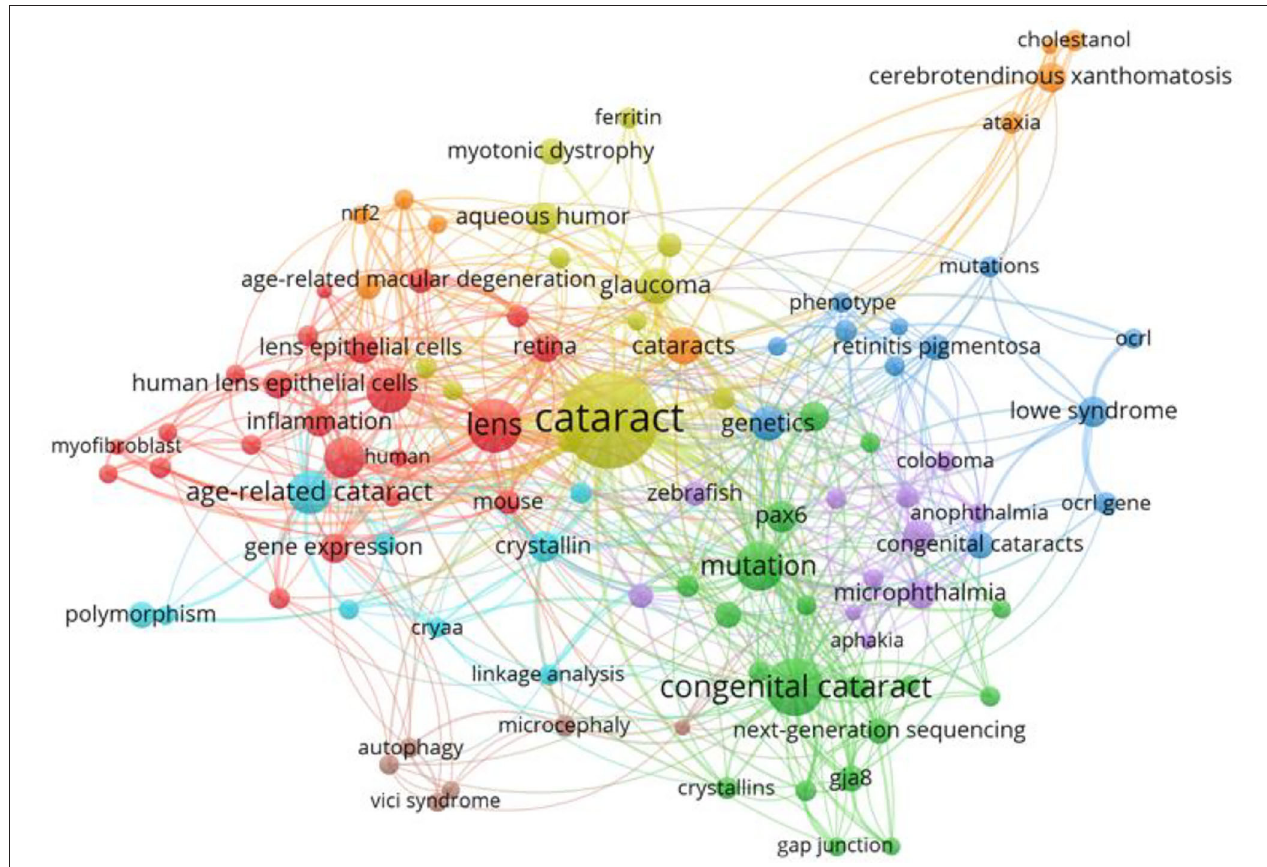
FIGURE 8 | The network map of keywords showed 58 keywords and divided into 5